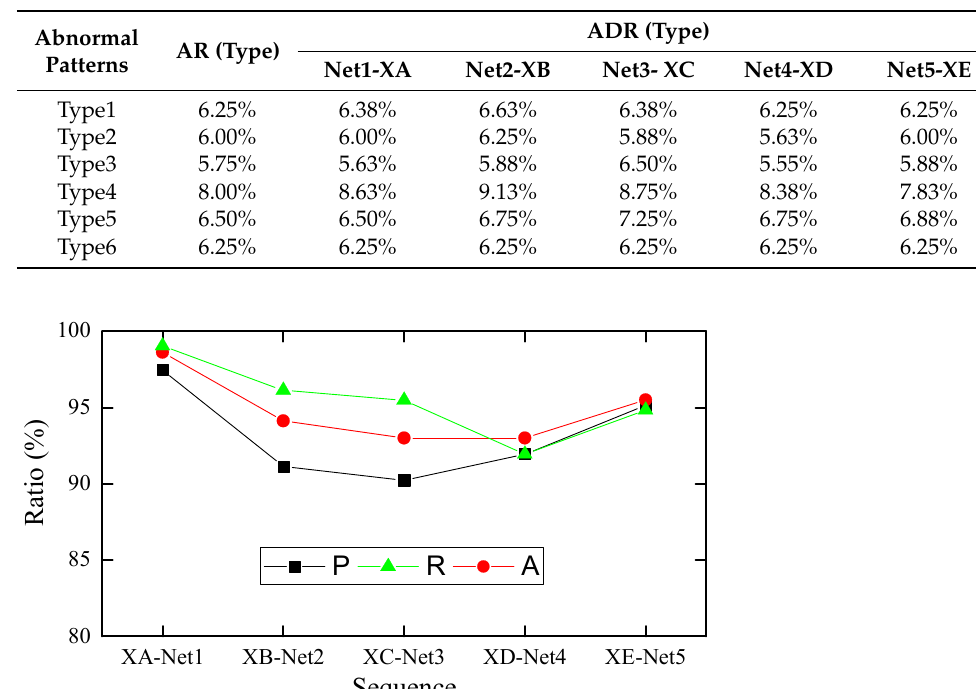
Table 3. Anomaly detection results of six types of abnormal patterns.